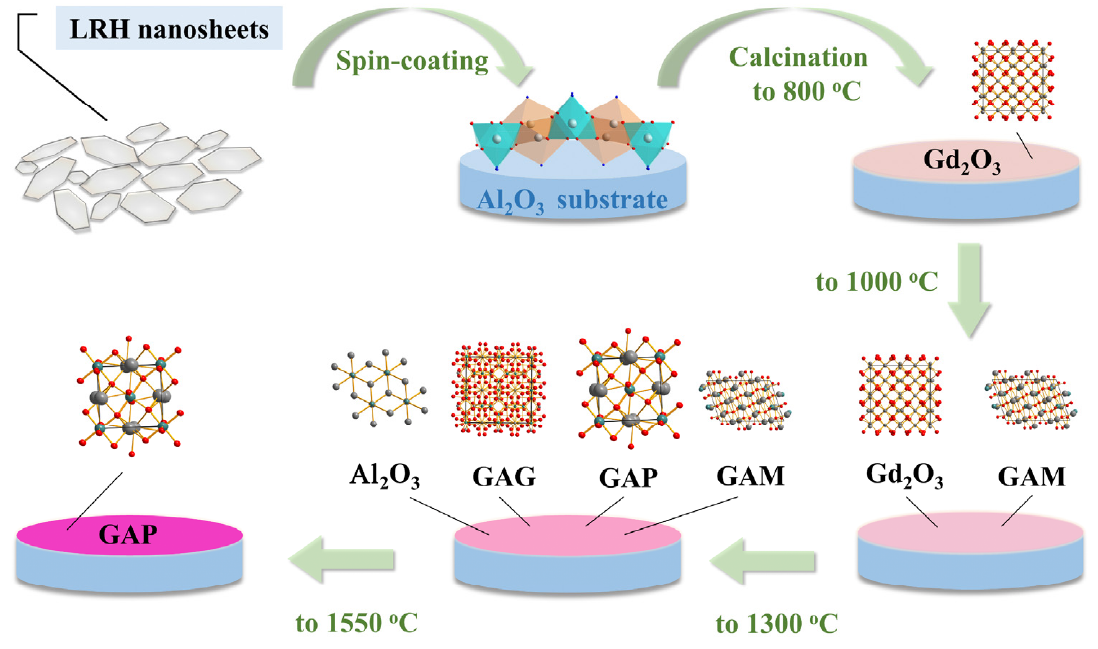
Figure 3. Schematic illustration for the fabrication of GdAlO 3 (GAP) ceramic films using exfoliated nanosheets as the rare-earth source. The intermediates GAM and GAG represent Gd 4 Al 2 O 9 and Gd 3 Al 5 O 12 , respectively.